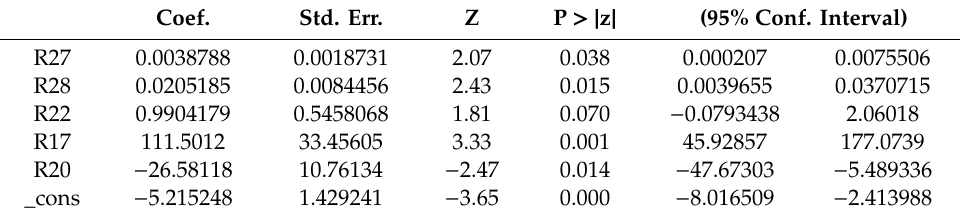
Table 10. Regression results one year before failure.